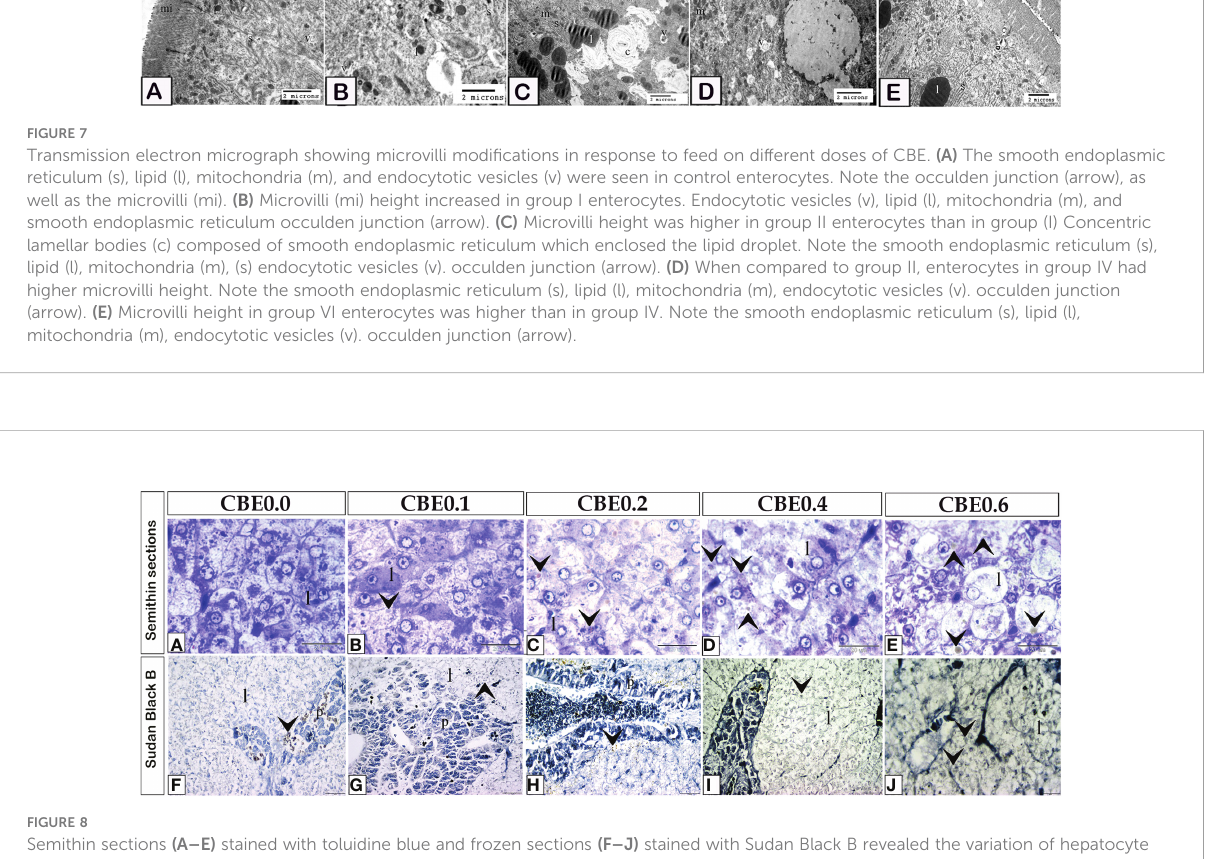
group CBE0.2. There was a highly signi fi cant difference (p <.01) between groups CBE0.0, CBE0.6, CBE0.1, CBE0.2, and CBE0. 4, but no signi fi cant difference between groups CBE0.0 and CBE0.6. (Table 7, Figure 12).